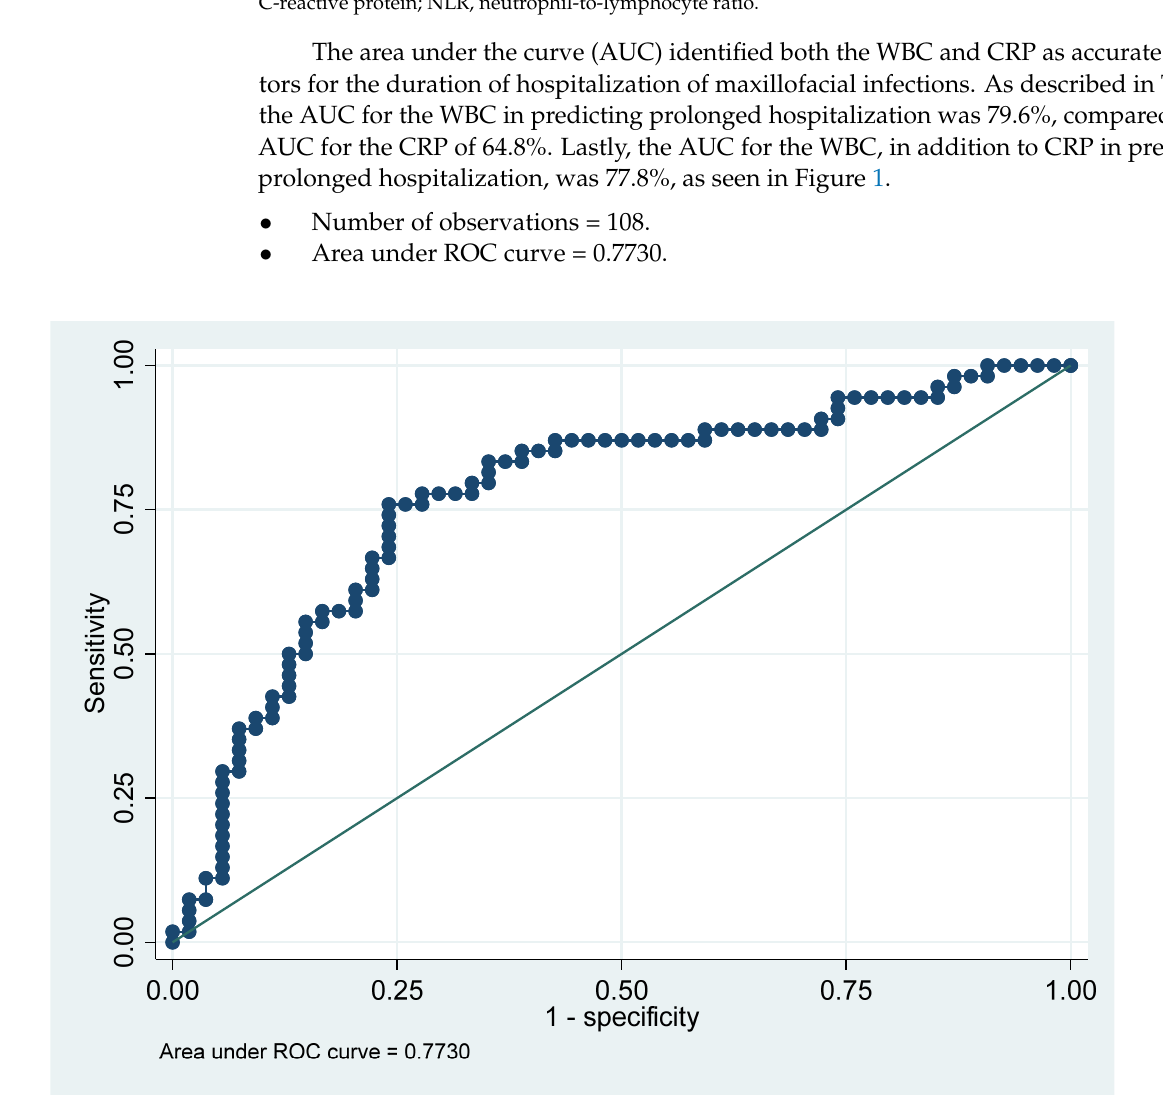
Figure 1. Area under the ROC curve (AUC) for WBC and CRP.